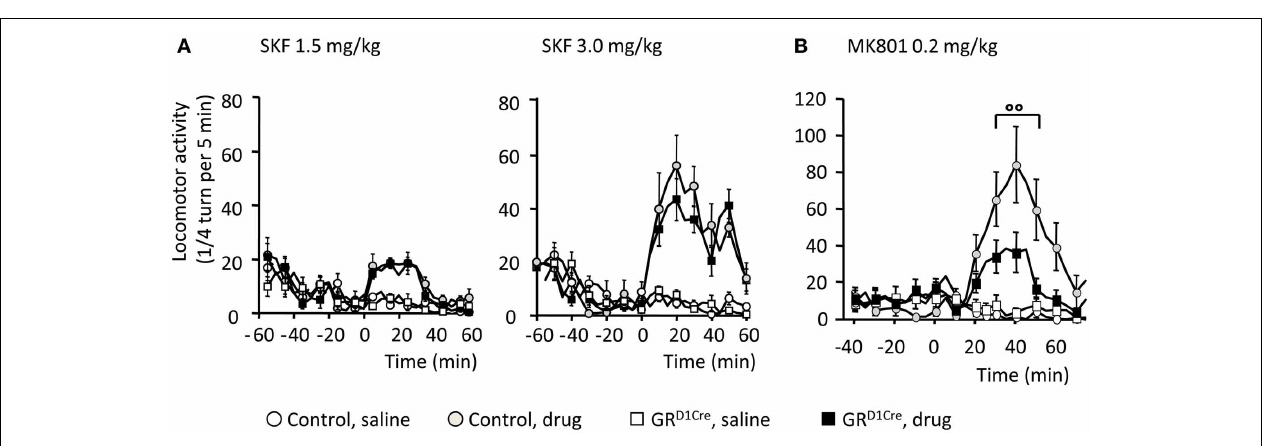
and 3mg/kg [ F ( 17 , 714 ) = 9 . 4, P < 0 . 001], but no interaction Drug × Time × Genotype, F ( 17 , 714 ) = 1 . 2, P > 0 . 05 and F ( 17 , 714 ) = 0 . 8, P > 0 . 05, respectively. (B) MK801 elicited a stronger hyperlocomotion in control than GR D1Cre mice, interaction Drug × Time × Genotype, F ( 18 , 756 ) = 1 . 9, P < 0 . 01. ◦◦ P < 0 . 01, control vs. mutant. n = 8–14 mice per